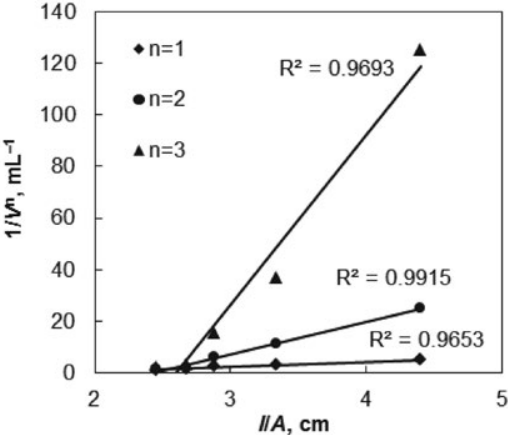
Figure 4. Determination of the molar ratio ( n ) Mo(VI):INT by the method of Asmus C = 2.08 × 10 ‒5 M; C Mo(VI) C